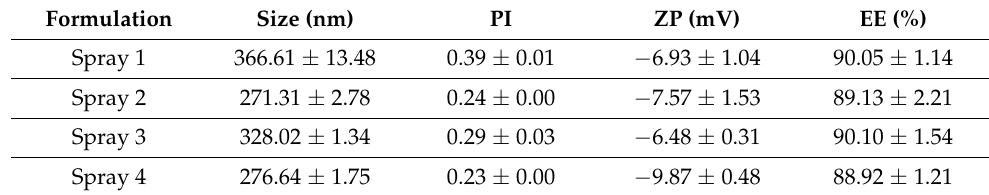
Table 2. Four different spray drying conditions of PGZ-NPs after resuspension in water.